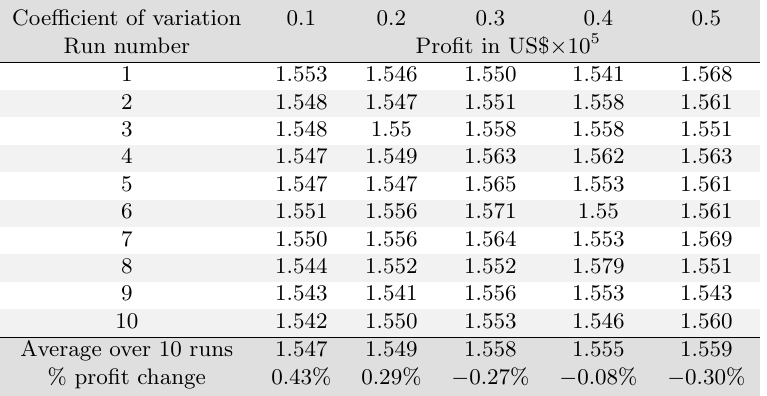
Table 9: Profit from random catch and variable trawler schedule for